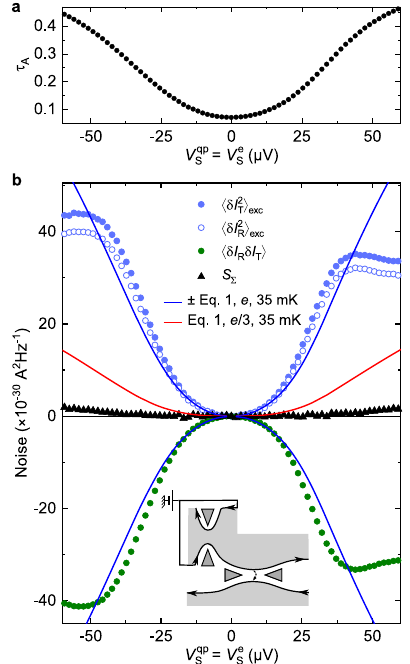
Fig.2|CharacterizationofanalyzerQPC,fromtransmission(a)andnoise(b)vs directvoltagebias V qp S = V e S .a Transmissionratio τ A ≡ I T / I S . b Measurementsofthe auto- and cross-correlations of the transmitted ( I T ) and re fl ected ( I R ) currents are shown as symbols. For small enough τ A ≲ 0.3 ( ∣ V qp S ∣ <35 μ V, see ( a )), the different noise signals corroborate the expected tunneling charge e (blue lines) in marked difference with e /3 predictions (red line). At higher τ A ≳ 0.3, the relatively smaller noise is consistent with the onset of the expected transition toward e /3. The noise sum S Σ (cid:2) h δ I 2 T i exc + h δ I 2 R i exc +2 h δ I T δ I R i , corresponding to the excess shot noise across the presently unbiased source, remains essentially